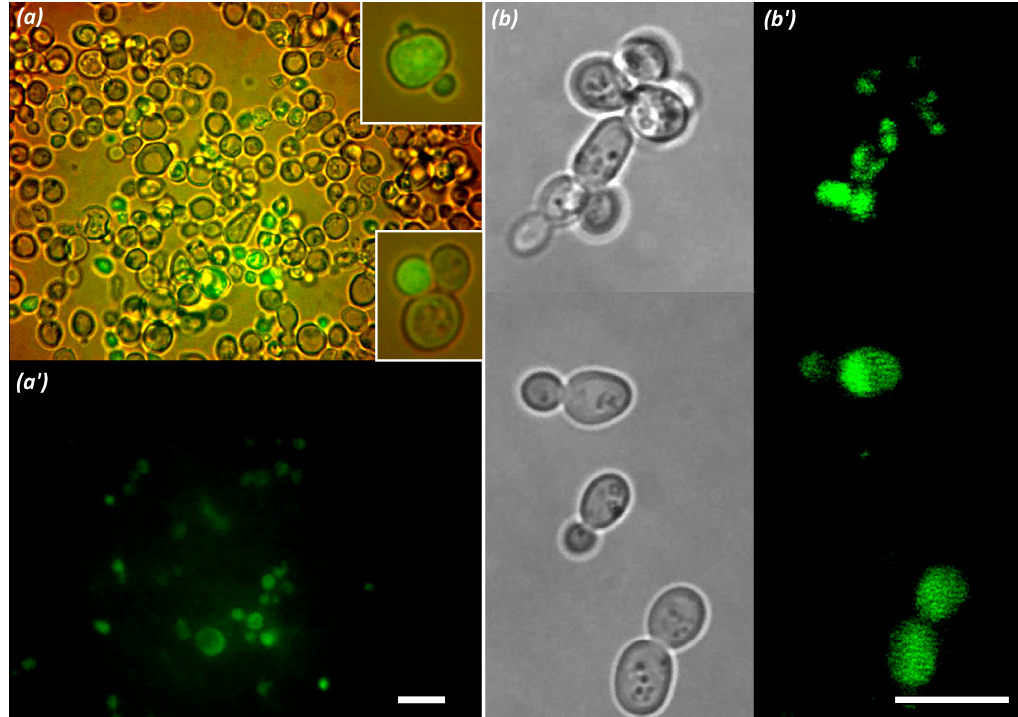
Figure 12. Images of S. cerevisiae cells after incubation with oligonucleotide-complexed polymer P23 ( a , a’ ), P22 (insertions in ( a )), and with oligonucleotide-complexed composite based on P01 polymer ( b , b’ ). Image ( a ) and insertion images are obtained by combining light illumination and fluorescent excitation, ( b ) shows light images, and ( a ’, b ’) show fluorescent images. Green fluorescence originates from fluorescent-tagged oligonucleotide. Composition of the complexes corresponds to line 19 in Table 3 ( a , a ’), line 20 in Table 4 (insertions in ( a )), and line 4 in Table 4 ( b , b ’). Complex: cell culture ratio was 1:3. Scale bars represents 10 μ m.